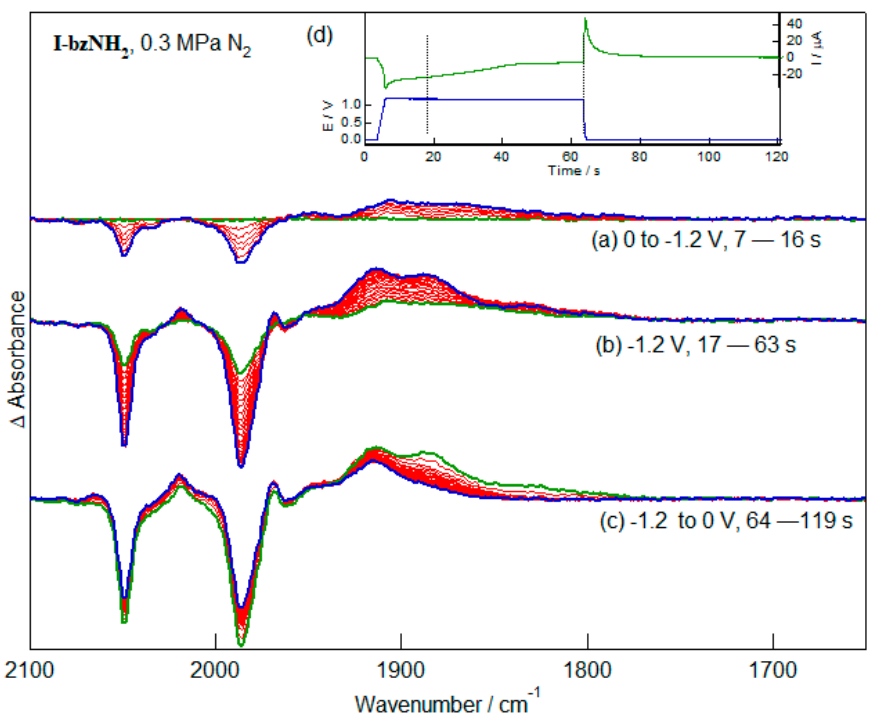
Figure 4. IR-SEC measurements of the reduction ( a , b ) and re-oxidation ( c ) of I-bzNH 2 . The applied potential and current response of the cell during the IR-SEC experiment is shown in ( d ). For this, and subsequent, figures the initial spectrum of each block is shown in green and the final spectrum in blue.